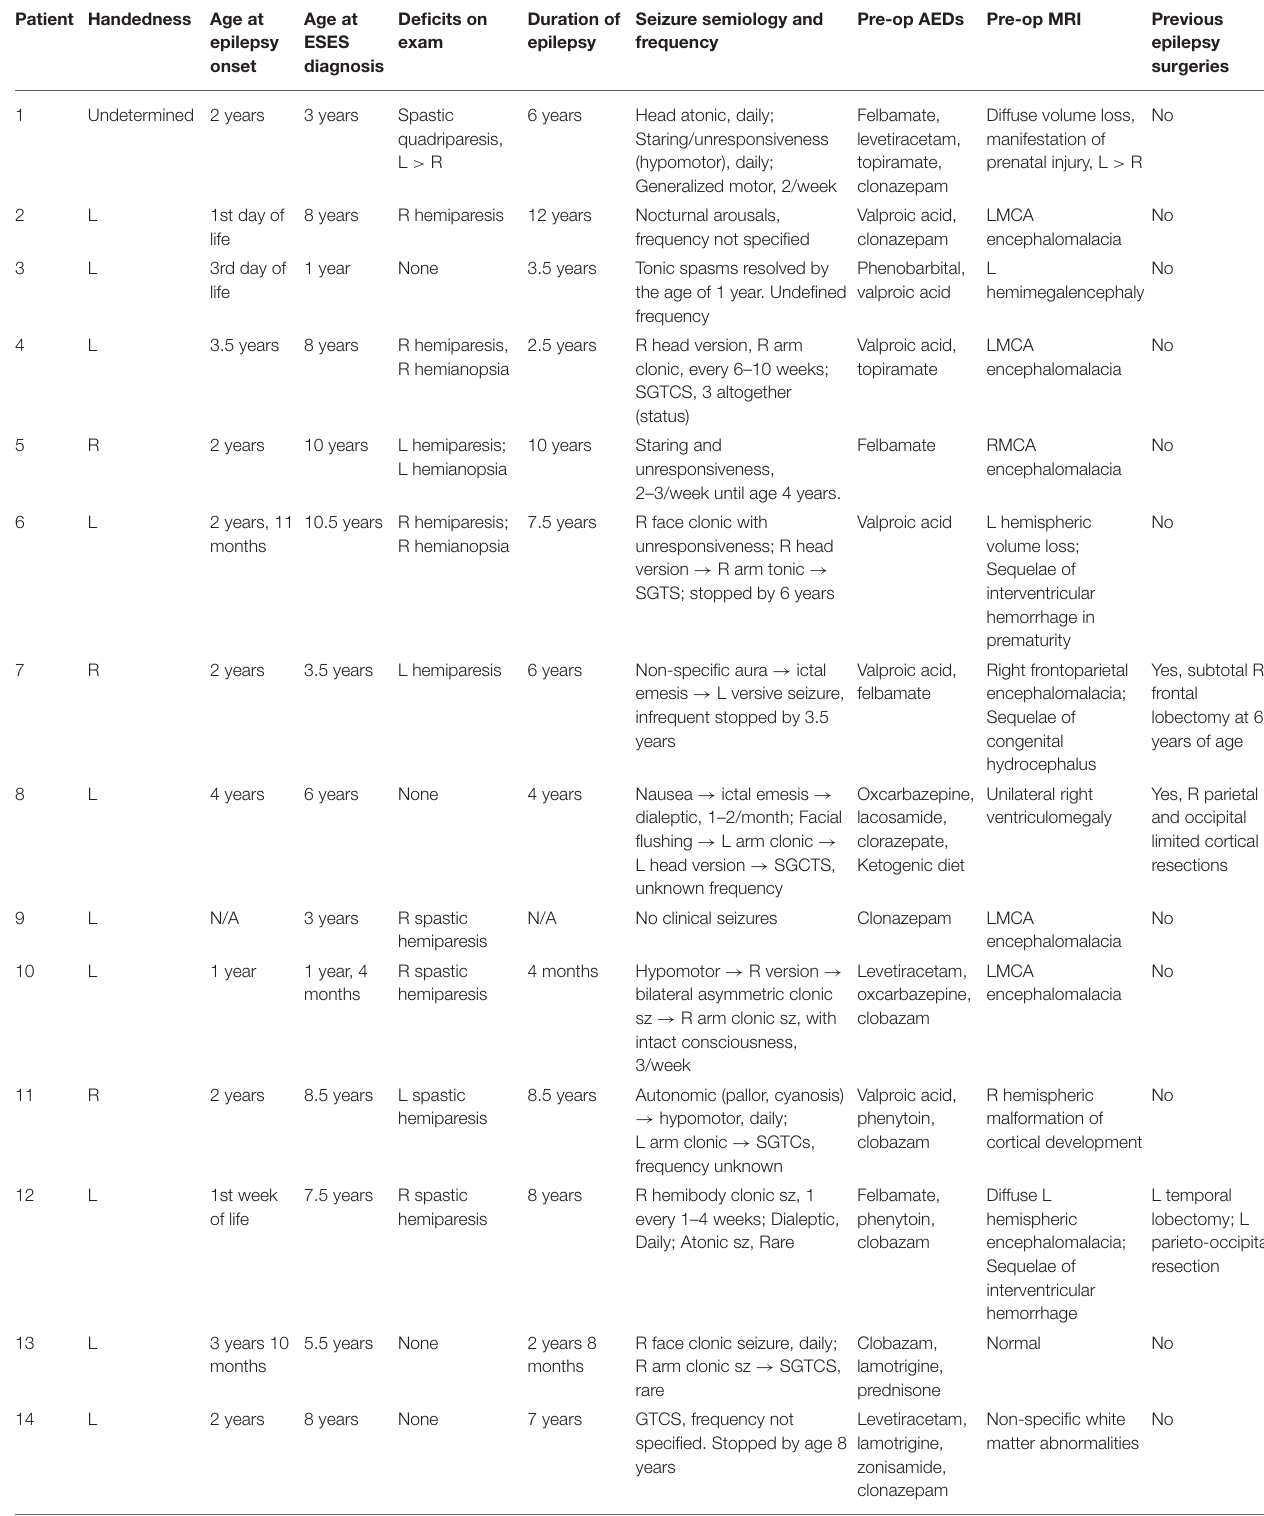
TABLE 1 | Presurgical clinical